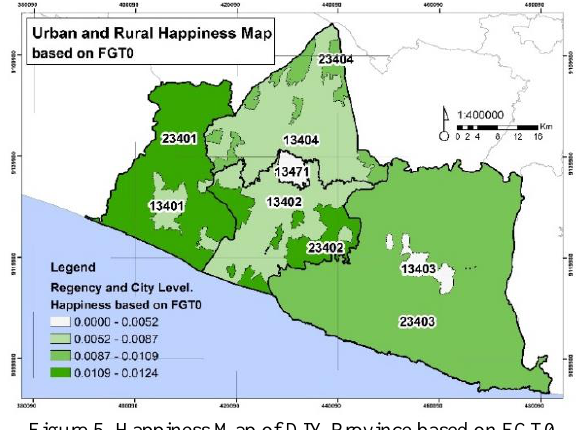
Figure 5. Happiness Map of DIY Province based on FGT0